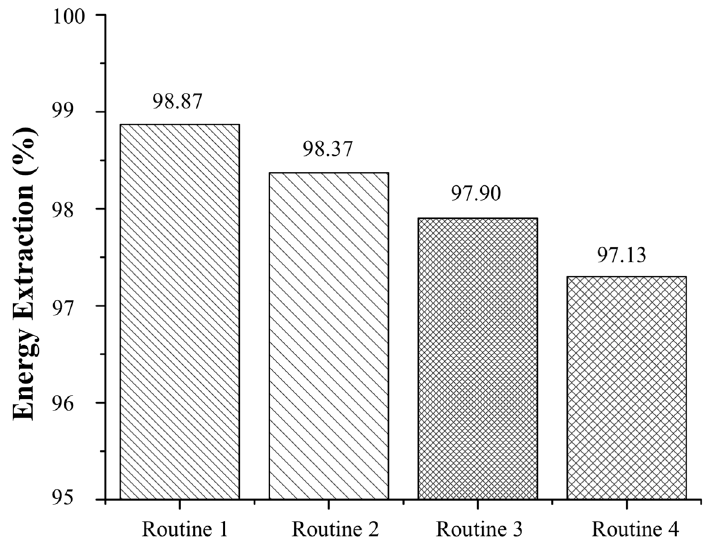
Figure 10. Average values calculated for energy extraction. Table 4. Calculated efficiency of the bank changeover circuit in all configuration routines.